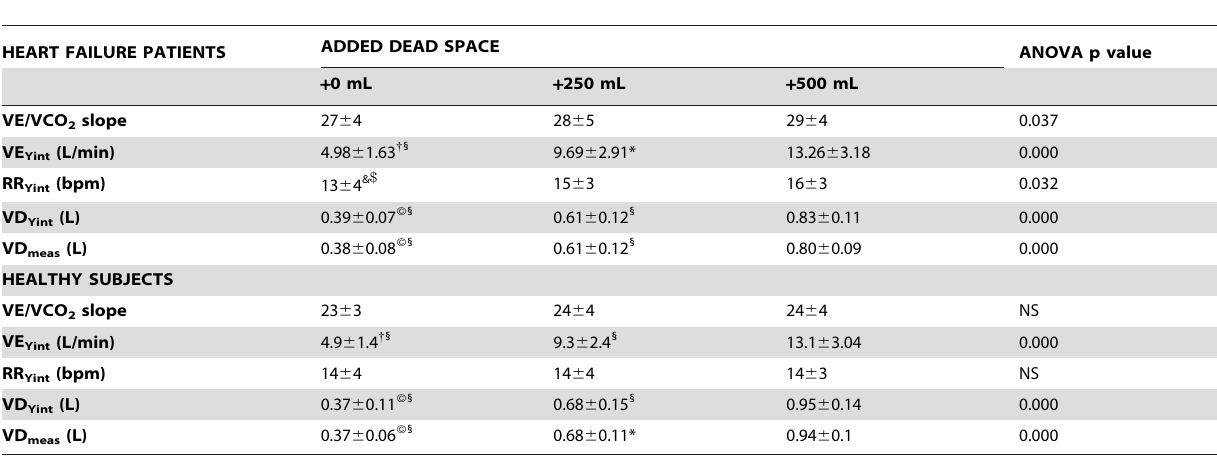
Table 4. Values of the slope of VE vs VCO 2 relationship, VE Yint , RR Yint and volume of dead space in heart failure patients (upper panel) and healthy subjects (lower panel) with 0 mL, 250 mL and 500 mL of additional dead space.